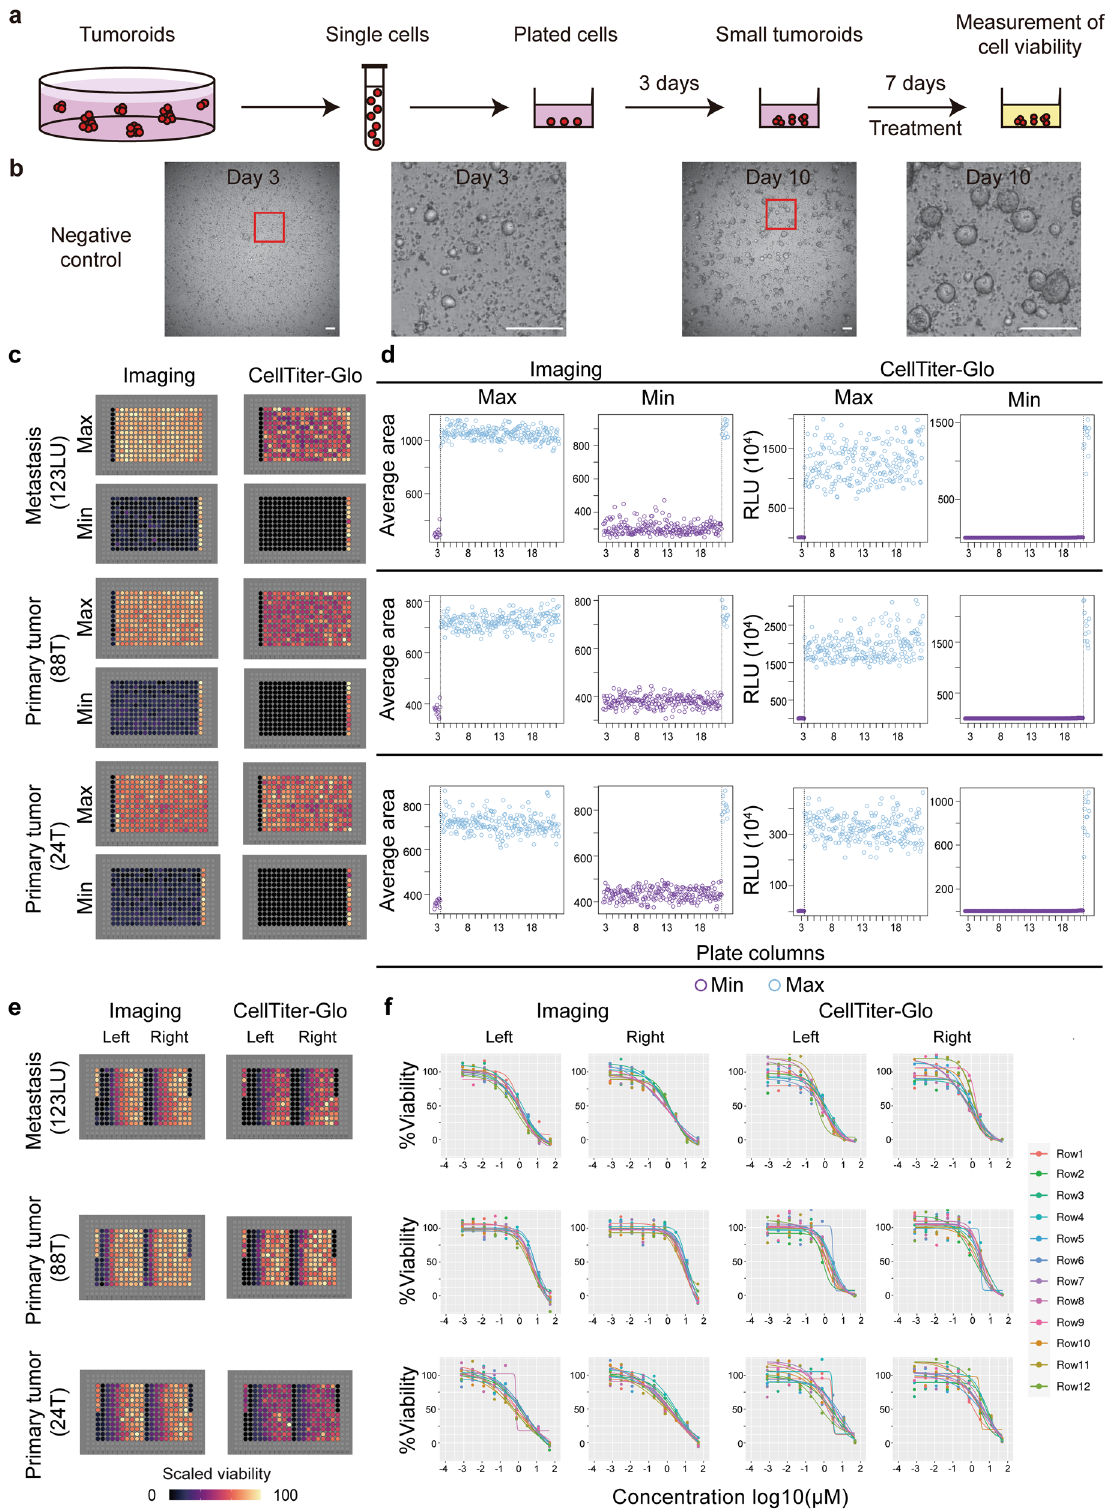
drug dose-response curves, with high concordance of curve fi ts evident between runs for all fi ve drugs (Fig. 9a). Accordingly, replicate experiments showed strong correlations for pGR 50 , GR max and GR aoc estimates, with Pearson ’ s correlation coef fi - cients of 0.94, 0.90, and 0.81, respectively ( p < 0.001 for all comparisons) (Fig. 9b –